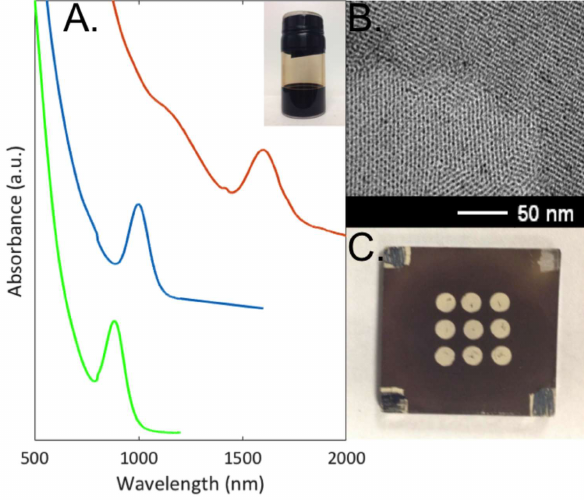
Fig. 1. (A) Solution-phase absorption spectra of PbS CQDs with ex- citonic peaks at wavelengths of 880, 1000 and 1600 nm. Spectra are offset for clarity. Inset: photograph of as-synthesized PbS CQD solution with excitonic peak at 955 nm. (B) Transmission electron microscope image of a large ensemble of PbS CQDs with excitonic peak wavelength of 950 nm. (C) Top-view photograph of a 3 × 3 array of PbS CQD photovoltaic cells (full substrate is 1 inch × 1